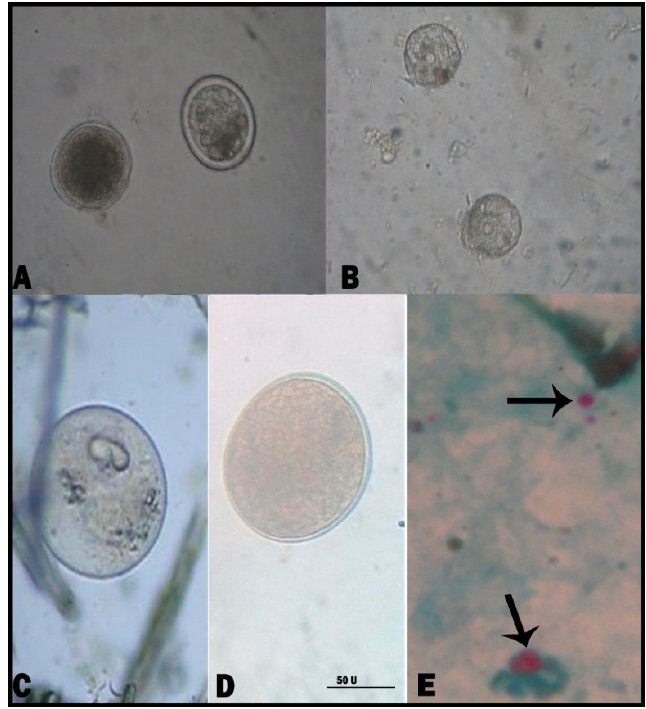
Figure 1. Diarrhea-causing intestinal parasites in cattle and buffalo calves (Plate 1). ( A ) T. vitulorum egg; ( B ) Moneizia species egg; ( C ) B. sulcata (trophozoite); ( D ) B. sulcata (cyst form); and ( E ) Cryptosporidium species (oocyst). (Scale bar = 50 μ m).